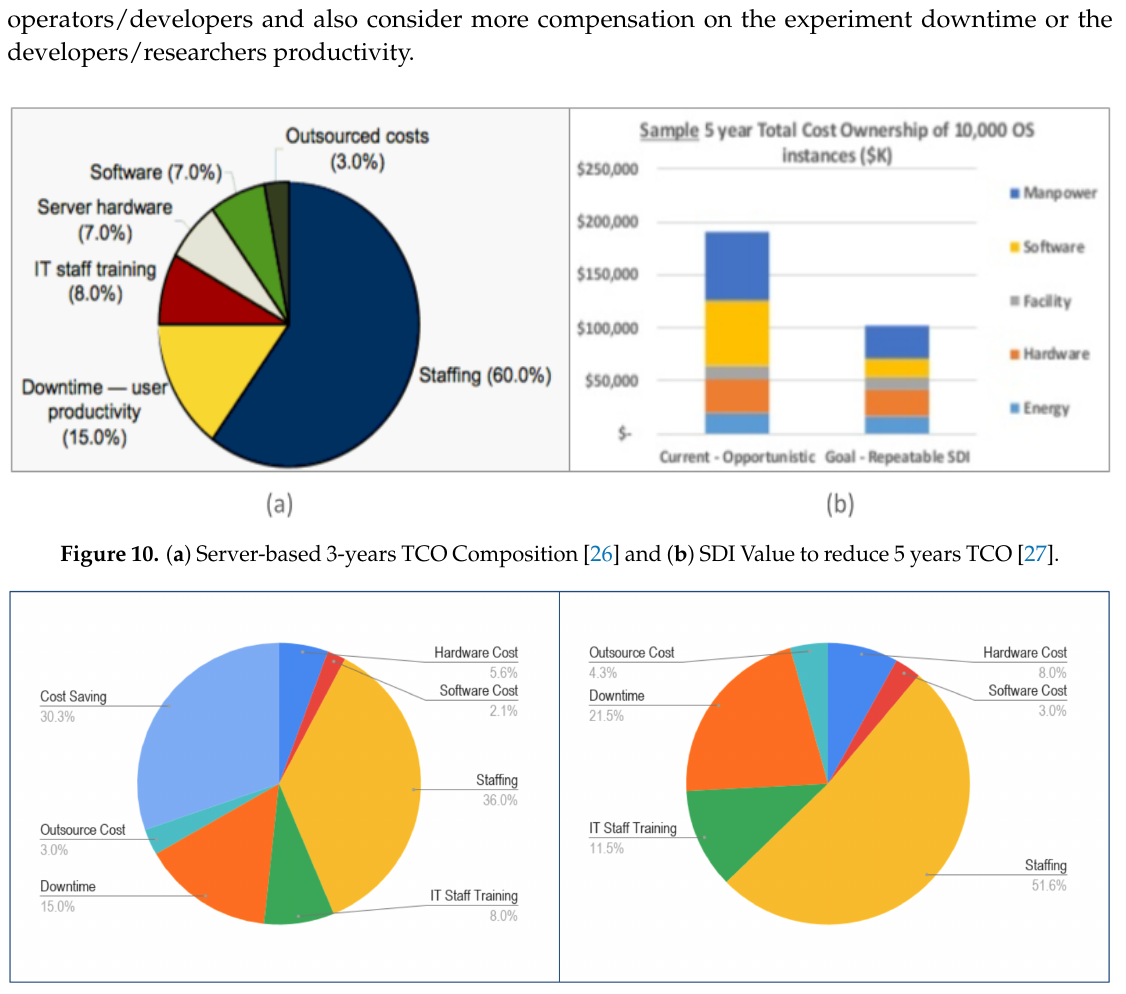
Figure 11. ( a ) TCO saving with hyper-converged infrastructure and ( b ) Normalized TCO with hyper-converged